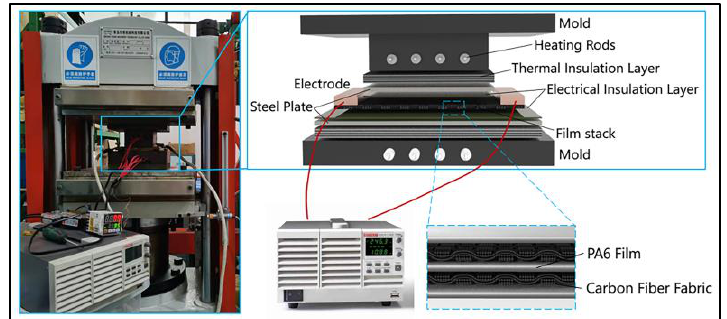
Figure 1. The photo image and schematic drawing of the hot compression mold for CF/PA 6 com- posite laminate with the SRE heating system.